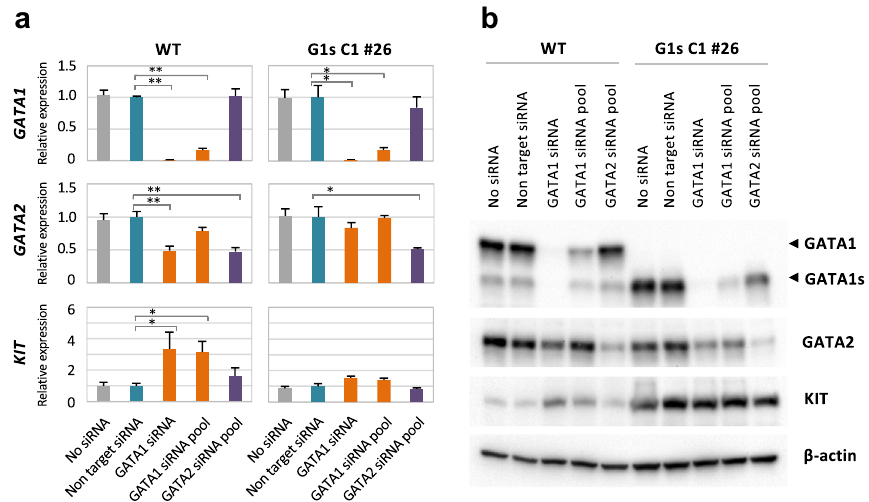
Figure 2. Changes in KIT gene expression by GATA1 siRNAs. ( a ) qRT-PCR analysis was performed for K562-WT (left) and one of the K562-G1s clone, C1 #26 (right). The vertical axis represents a relative value with each value of non-target siRNA set at 1. Results are averages of three independent experiments. Error bars represent standard deviation. * P < 0.05, ** P < 0.01 (two-side t-test). ( b ) Representative immunoblots of siRNA experiments with K562-WT (left) and G1s C1 #26 (right). Western blotting was performed with anti-GATA1 antibody (D24E4, Cell signaling technology), anti-GATA2 (AF2046, R&D) anti-c-Kit (SC-17806, Santa Cruz) and anti-β-actin antibody (Sigma-Aldrich). Images were obtained using ChemiDoc